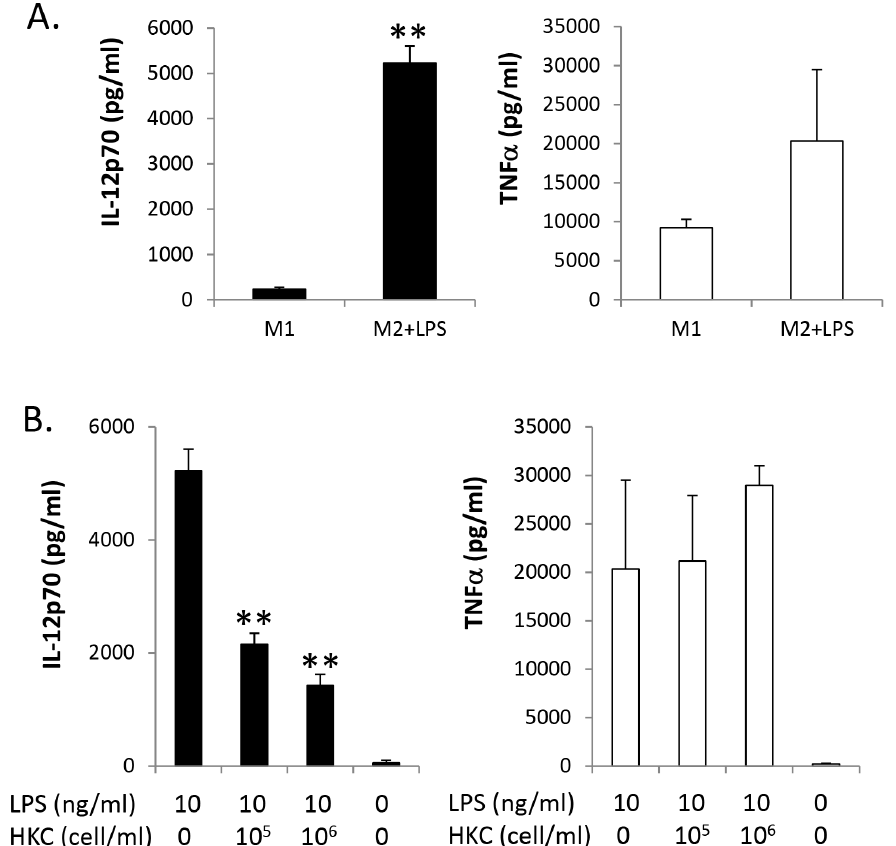
Figure 2. Heat-killed C.albicans inhibits LPS-induced M2 to M1 shifting for IL-12p70 production. A. M1 and M2 macrophages were stimulated with 10 ng/ml LPS for 48 h before harvesting the cell culture supernatant to detect IL-12p70 and TNF a expression via ELISA. B. M2 macrophages were stimulated with increasing concentrations of HKC plus 10 ng/ml LPS. IL-12p70 and TNF a production was quantified by ELISA. The results are representative of three experiments. **p , 0.01.